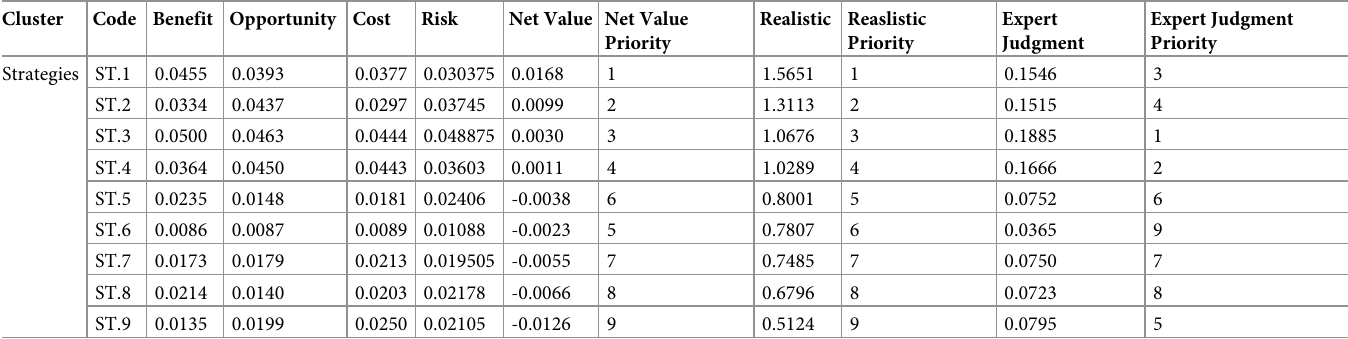
Table 6. ANP Results of strategies.